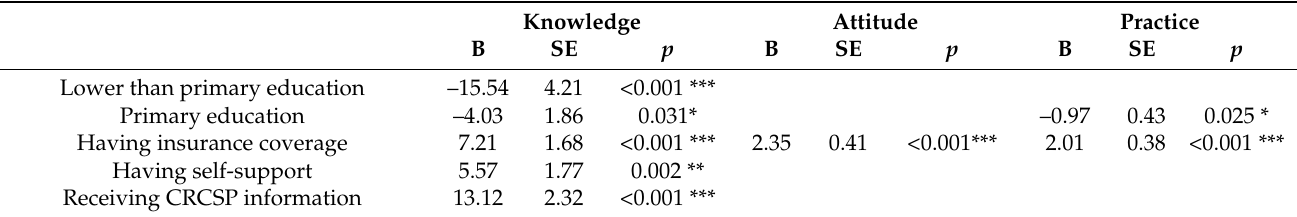
Table 3. Results of multivariate regression for factors associated with KAP towards colorectal cancer screening. Knowledge